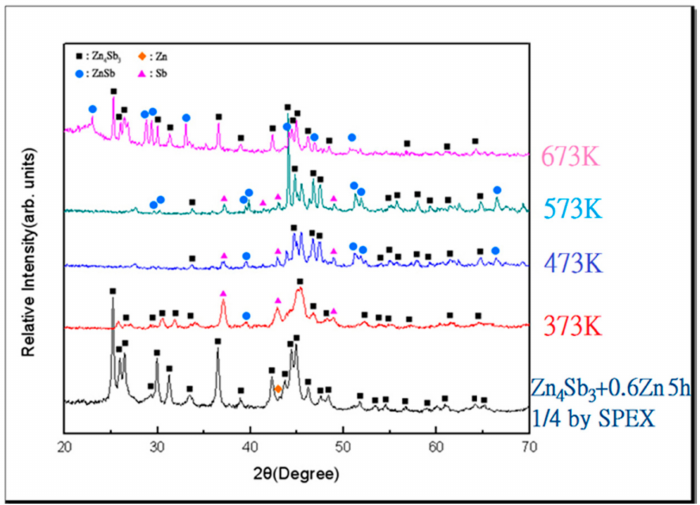
Figure 3. XRD patterns of bulk specimens with 0.6 at. % Zn rich composition hot pressed at different temperatures. Pressure: 0.98 GPa, time: 30